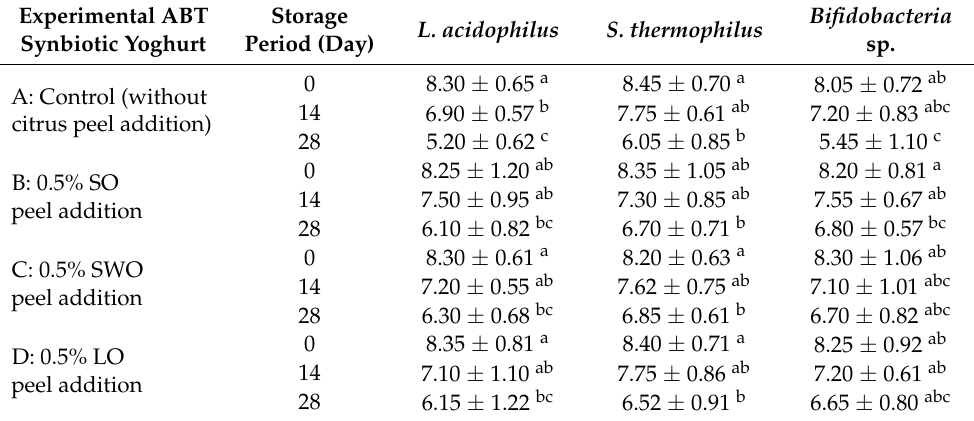
Table 4. Viable counts (Log CFU/g) of L. acidophilus , S. thermophilus , and Bifidobacteria sp. in ABT